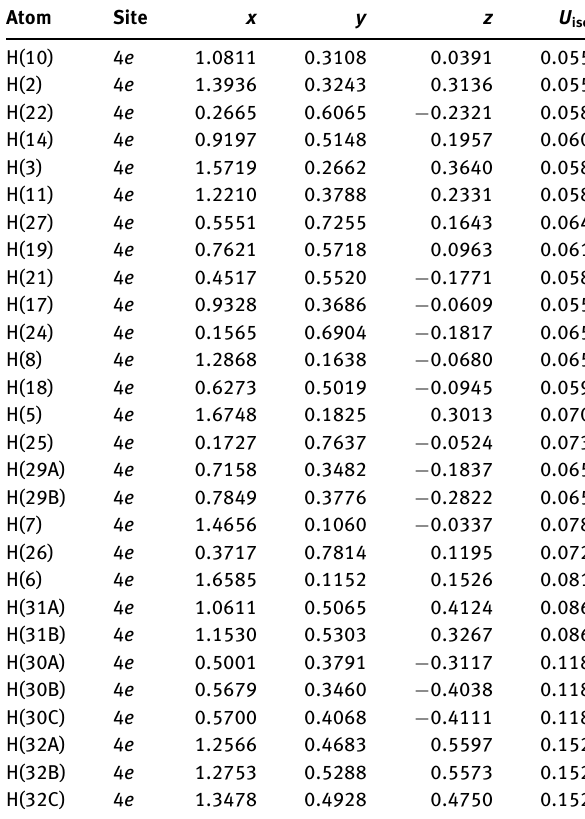
Table 2: Fractional atomic coordinates and isotropic or equivalent isotropic displacement parameters (Å 2